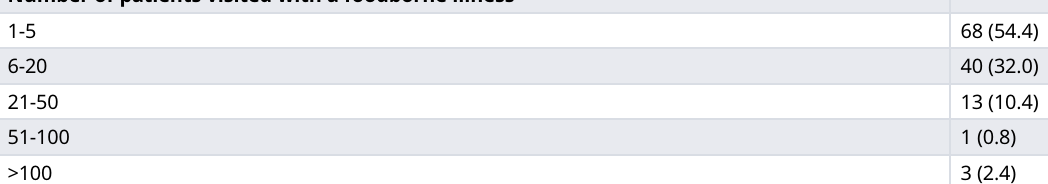
Table3showstheresultsfromthetest-retestanalysisusingthePearson correlationcoefficient(r).Correlation coefficients